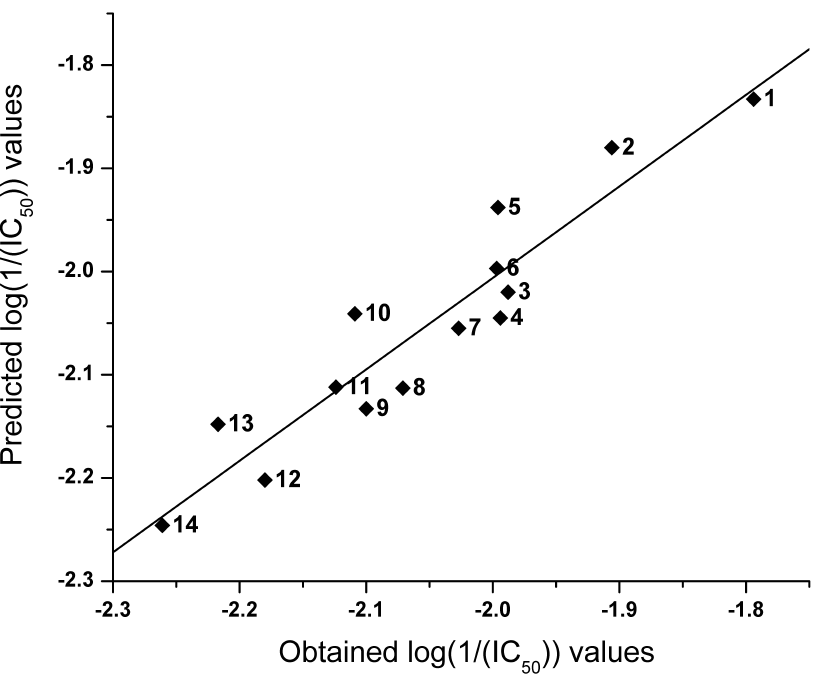
Figure 2. Correlation of predicted (from Eq. 1) and experimentally obtained log(1/(IC